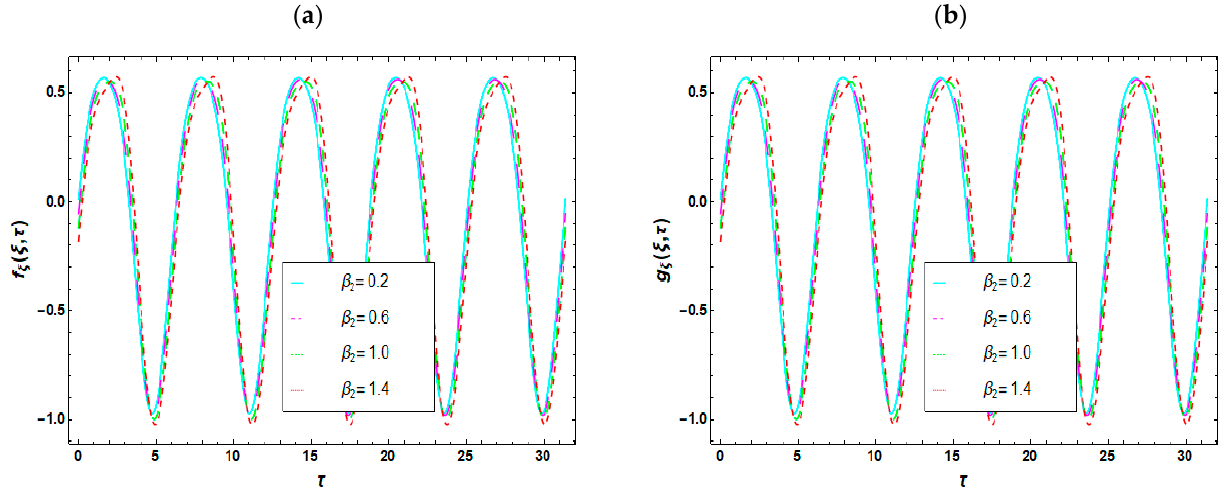
β values and ( b ) temporal variations in g ξ 2